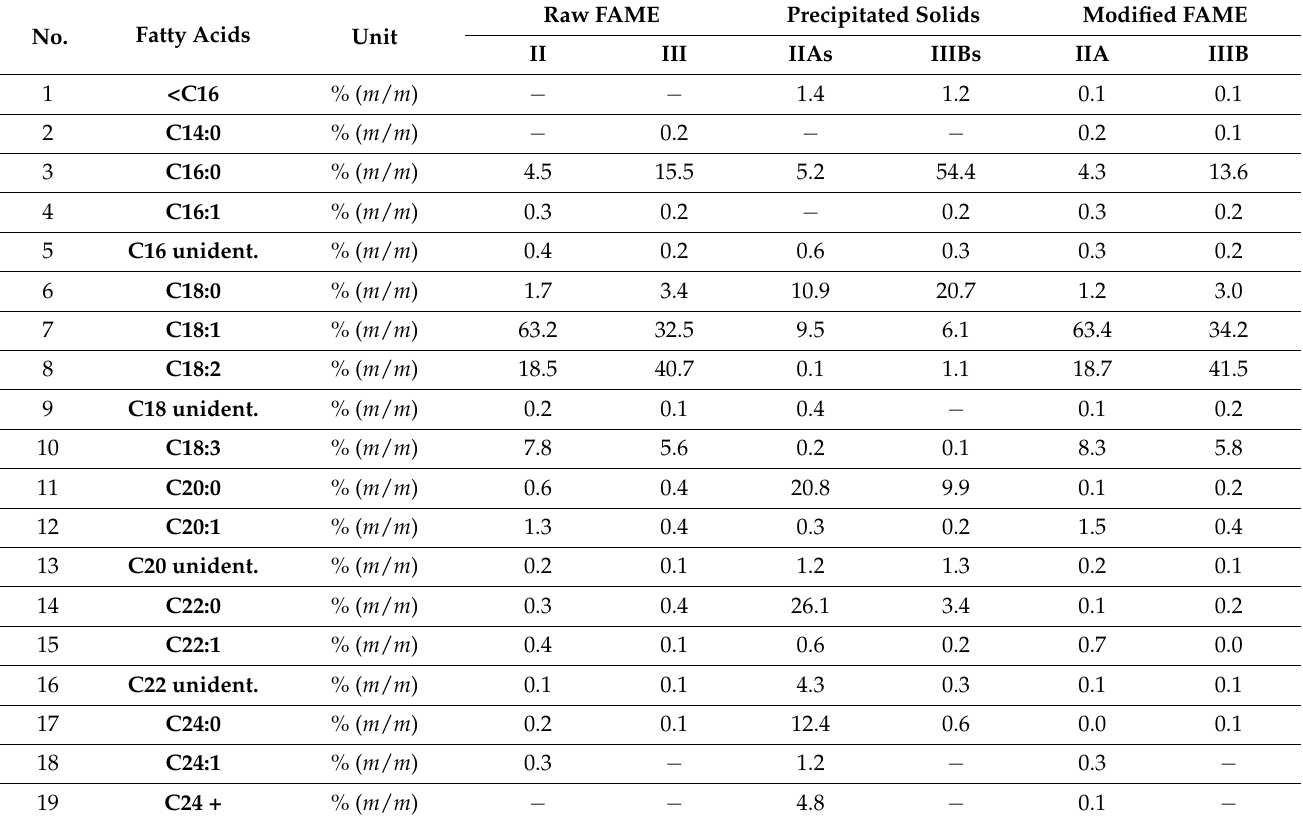
Table 5. Results of studies on fatty acid profiles in raw FAME (II and III), modified biofuels, and precipitated solids obtained in tests IIA and IIIB. precipitated solids obtained in tests IIA and